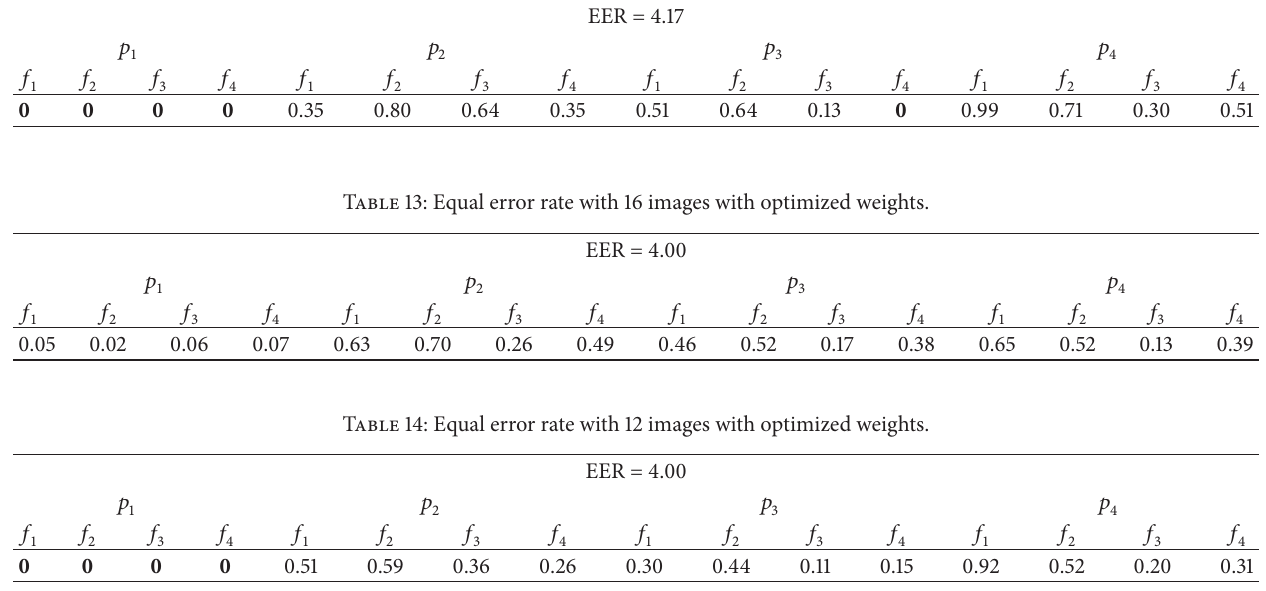
Table 12: Equal error rate with 11 images with optimized weights.